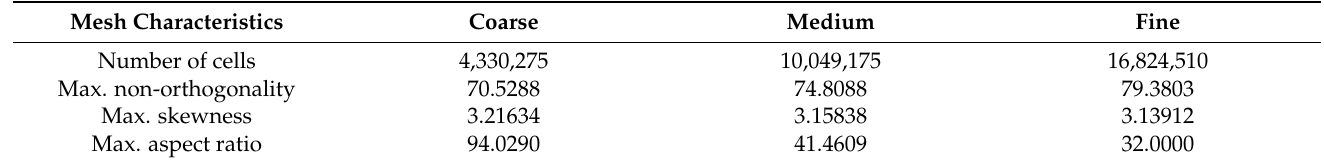
Table 4. Mesh characteristics for convergence analysis.